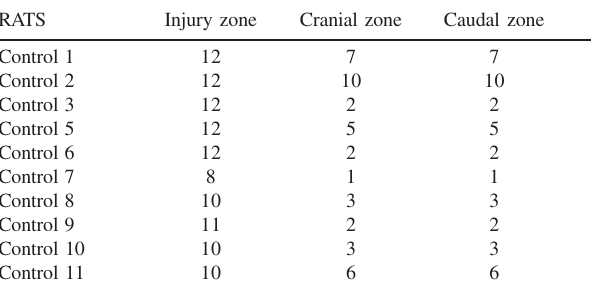
Table 5 - Final histological score, control group